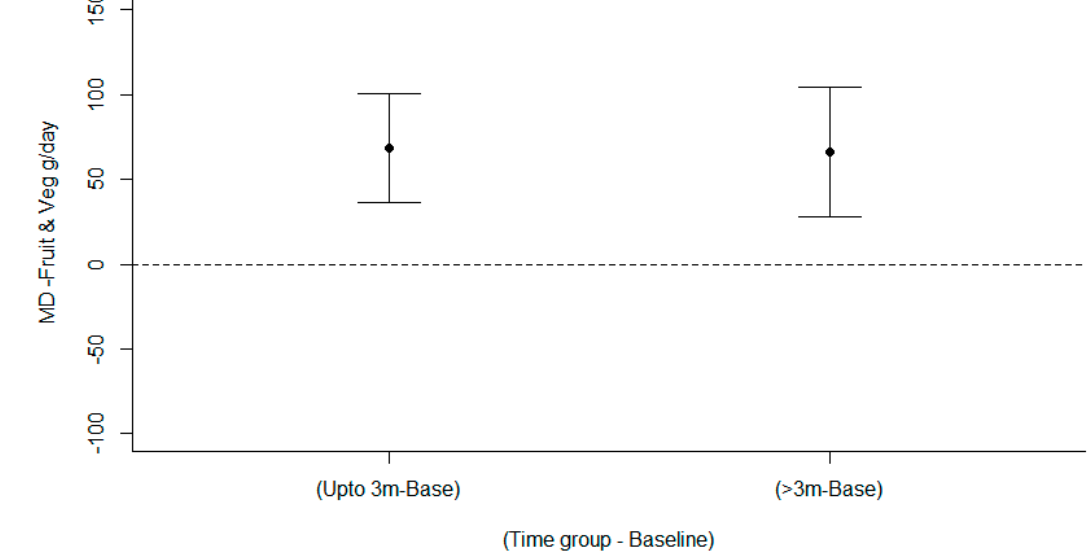
Figure 4. Mean di ff erences between arms in fruit and vegetable intake (g / day) over Figure 4. Mean differences between arms in fruit and vegetable intake (g/day) over time.